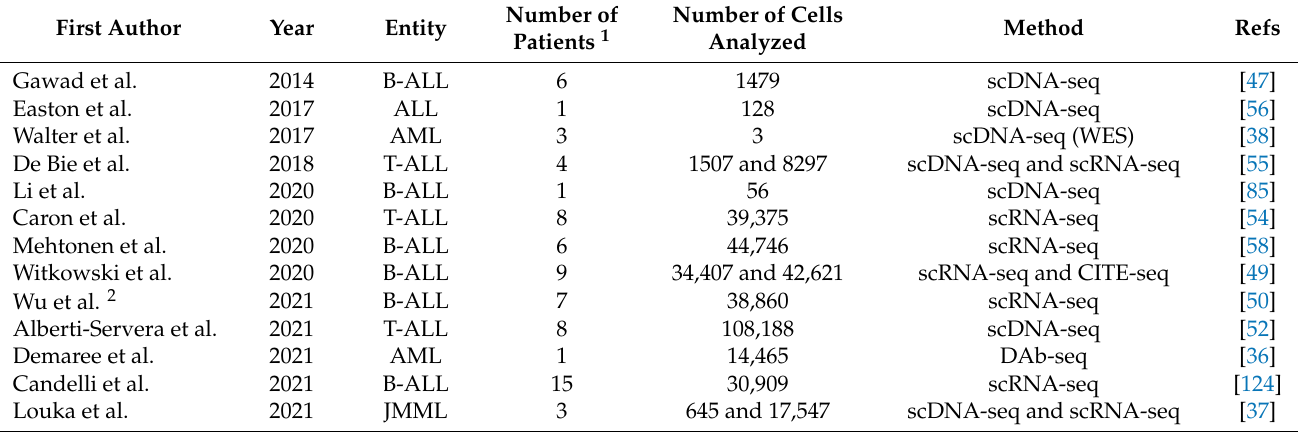
Table 2. Single-cell sequencing studies on primary samples of patients with pediatric